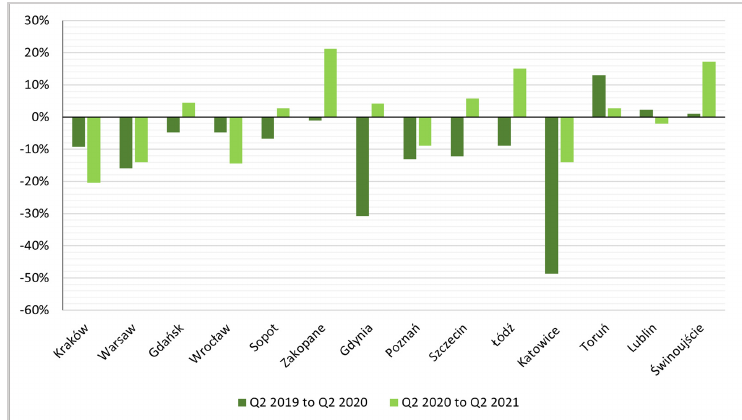
Figure 6. Indices of dynamics of changes, Q2 2019 to Q2 2020 and Q2 2020 to Q2 2021.